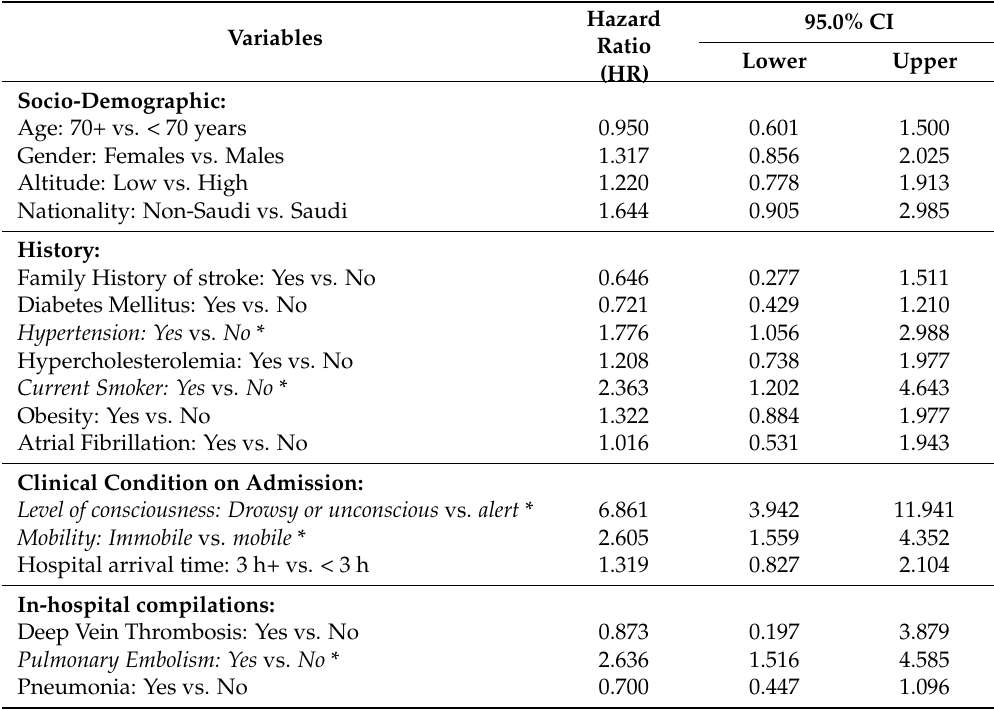
Table 3. In-hospital First-time Stroke Mortality Predictors (Cox regression Hazard Ratio) and concomitant 95% Confidence Intervals (95%